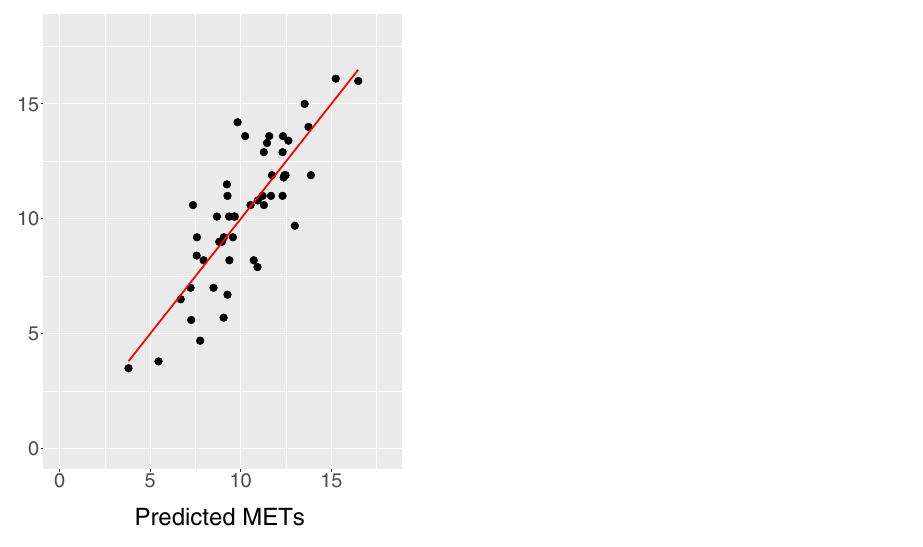
Figure 1. Observed Versus Predicted METs in Entire Study Population. The plot depicts observed versus predicted METs in the entire study population. The red line represents the line of